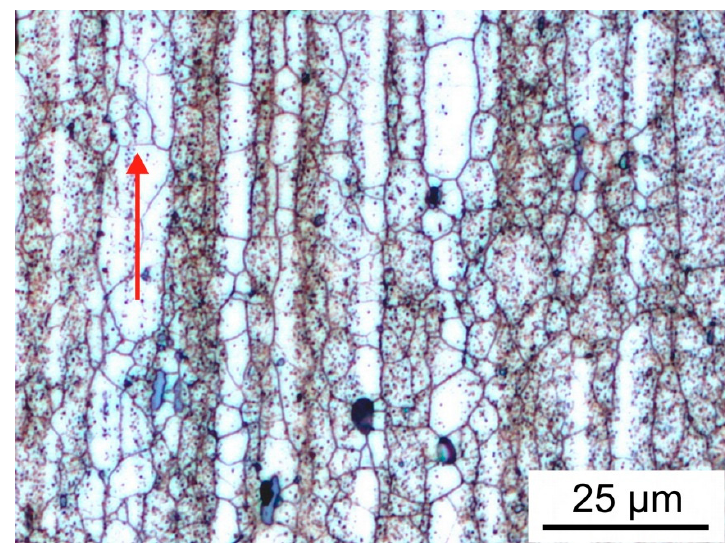
Figure 3. Structure of grains in longitudinal direction–extruded rod (extrusion direction indicated by the red arrow).